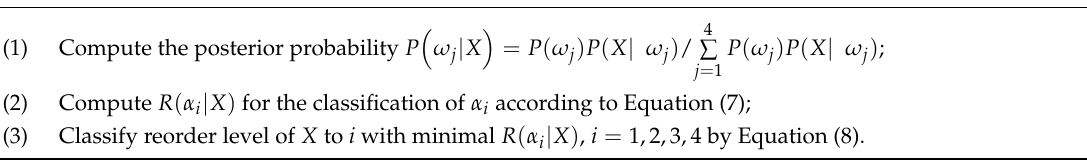
Algorithm 4. Conditional expected loss-based classification.